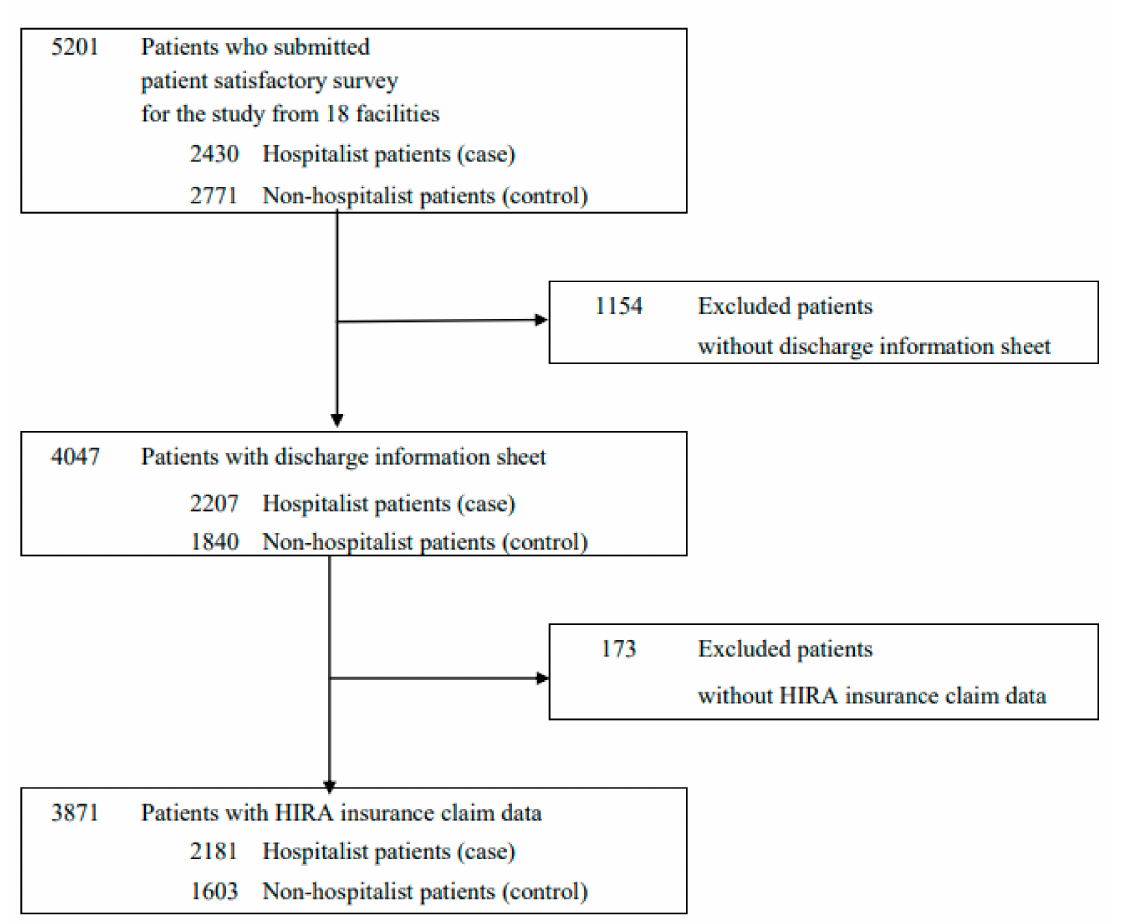
Figure 1. Flowchart of study population